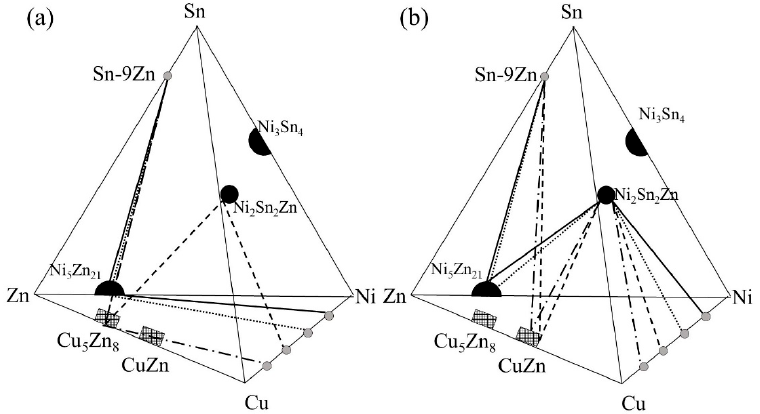
Figure 9. Two reaction stages of the Sn-Zn/Ni(Cu) joints superimpose on the Zn-Sn-Ni-Cu isothermal tetrahedron at 250 °C during ( a ) early stage; and ( b ) later stage.